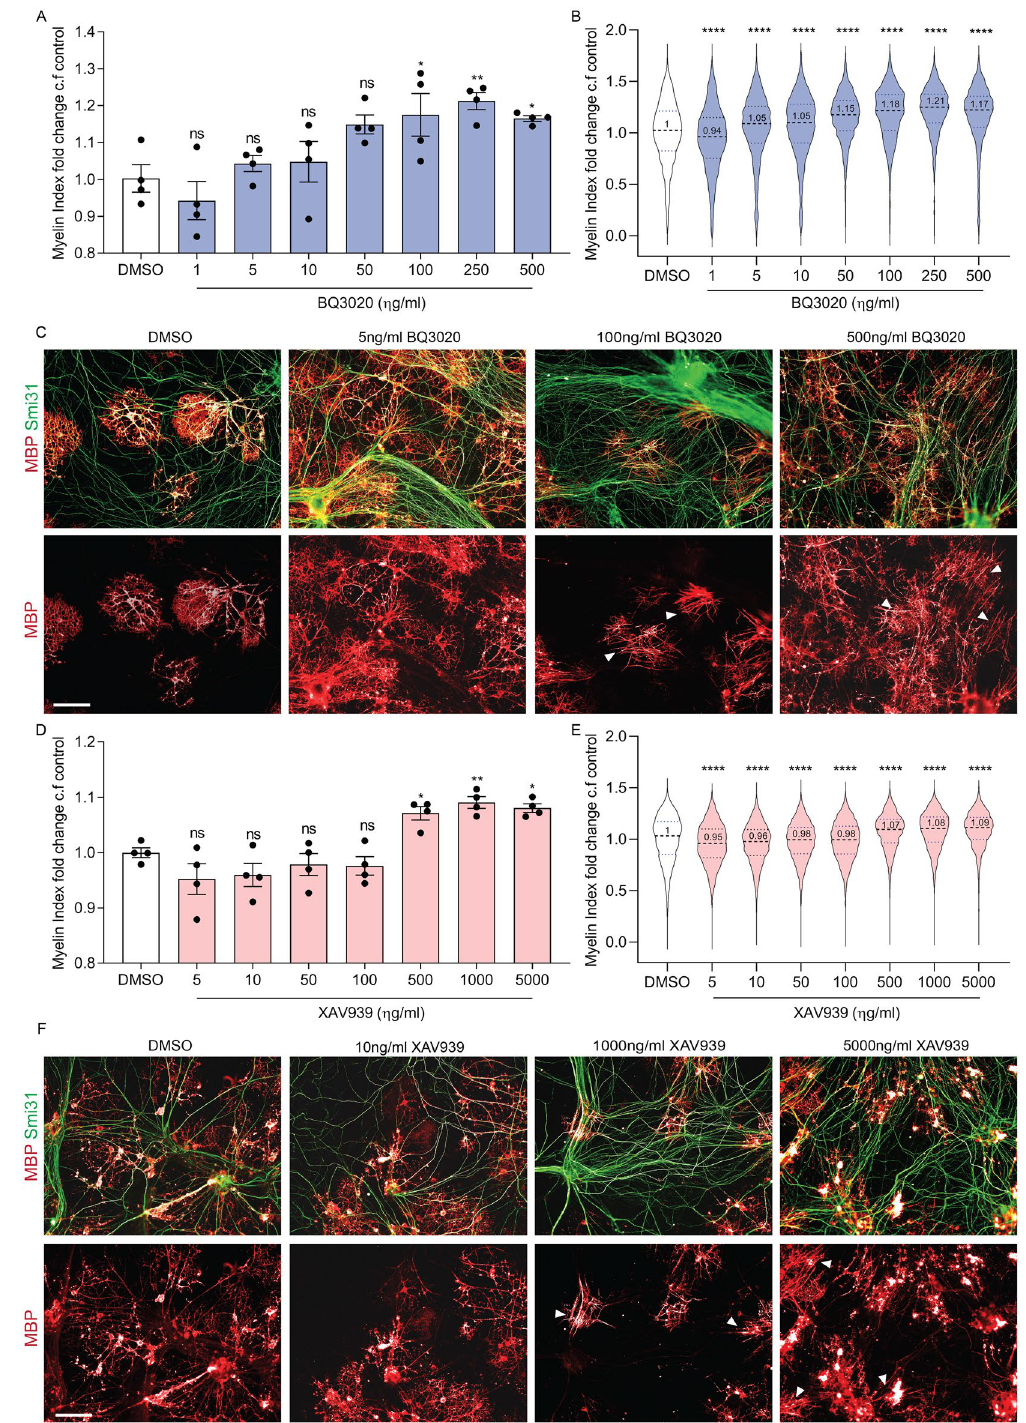
Figure 7. BQ3020 and XAV939 facilitate myelination in vitro . Quantification of myelination (myelination index) of RGC–OPC co-cultures treated with increasing concentrations of ( A ) BQ3020 (1–500 ng/ml) and ( C ) XAV939 (1–5000 ng/ml) for 7 days and normalized to DMSO control. Myelin index of the OL population per condition plotted as violin plot in ( B ) for BQ3020 treatments and ( E ) for XAV939 treatments normalized to DMSO control. Representative images of fluorescent MBP (red) and Smi31 (green) of C) BQ3020 and ( F ) XAV939 conditions compared to DMSO used for quantification (scale bar 100 µm). White arrows indicate axons wrapped with compact myelin by an adjacent OL. Individual values show mean ± SEM; Violin plots show median and quartiles as well as the mean as number, 4 biological replicates were done, analysis was done by one- way ANOVA followed by Dunnett’s multiple post hoc test for comparing more than three biological samples, ns not significant, *P < 0.05, **P < 0.01, ***P < 0.001, ****P <